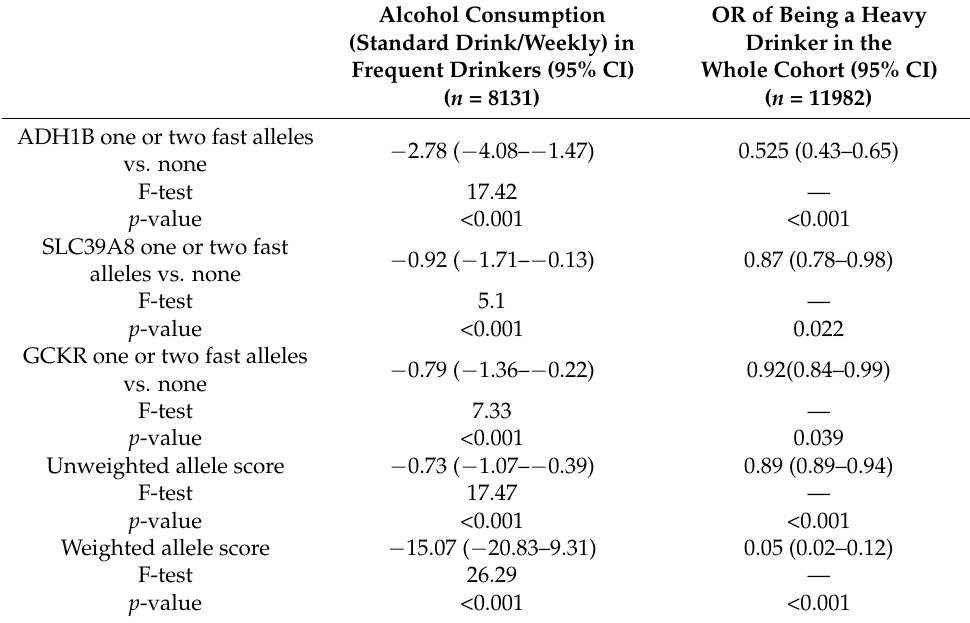
Table 2. Association of genetic variations of ADH1B/SLC39A8/GCKR with alcohol consumption in white